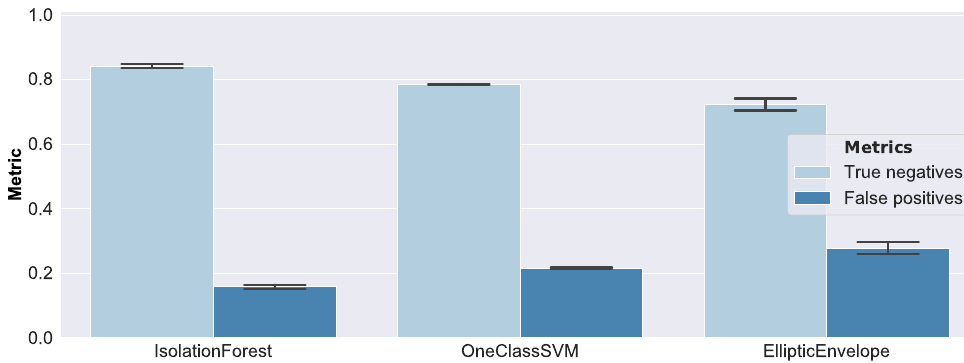
Figure 14. Anomaly detection results, on synthetic data, of small debonding radii of 2.2mm and